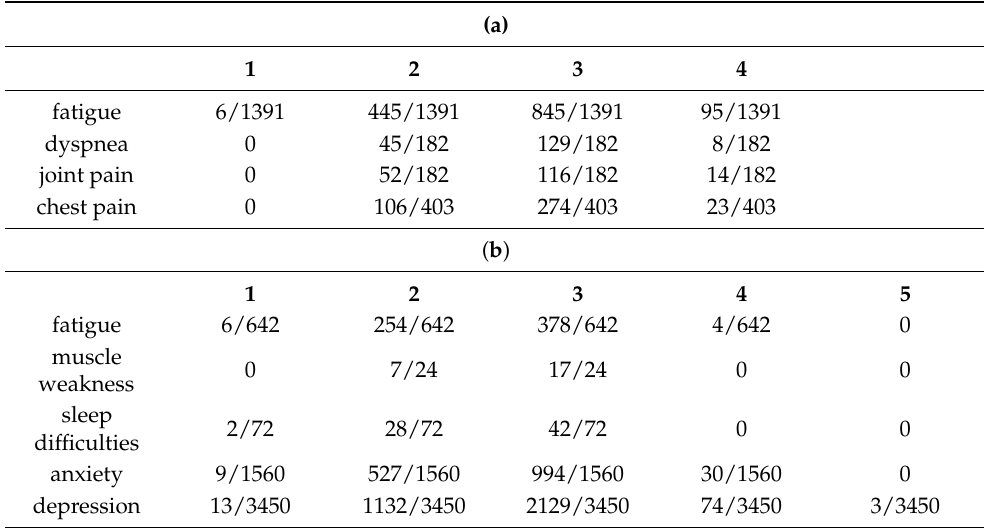
Table A1. ( a ). Path values and proportions of COVID-19 genes and different symptom genes in Europe. ( b ). Path values and frequencies of COVID-19 genes and different symptom genes in